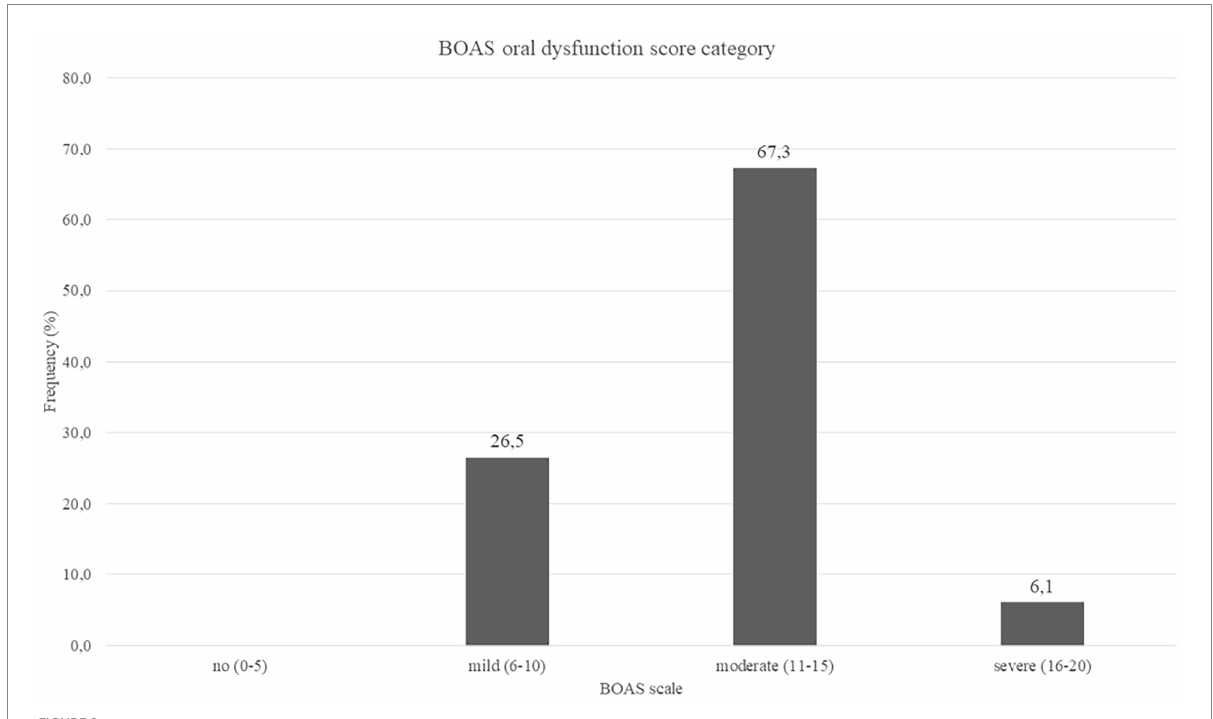
FIGURE 2 Baseline BOAS oral dysfunction score category, N = 49, data presented as percentages.